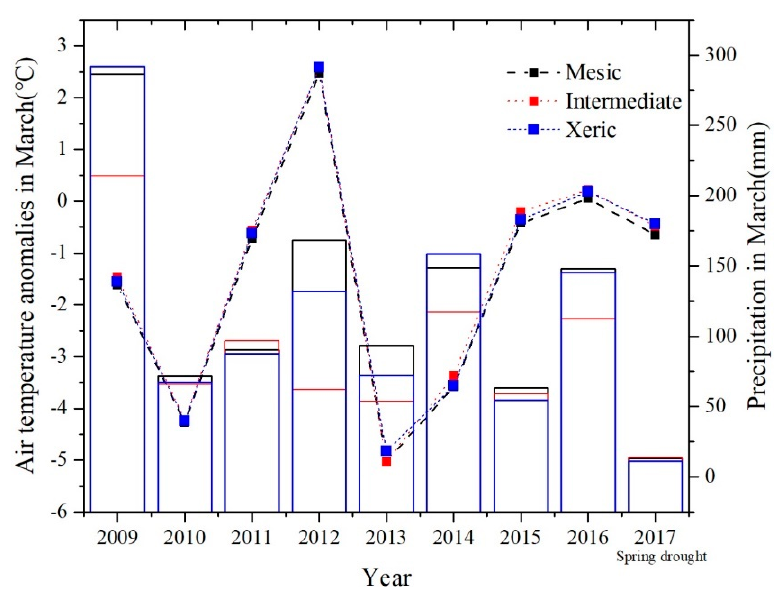
Figure A4. Precipitation and air temperature anomaly in March by site (dotted line represents the air temperature, bars represent precipitation).